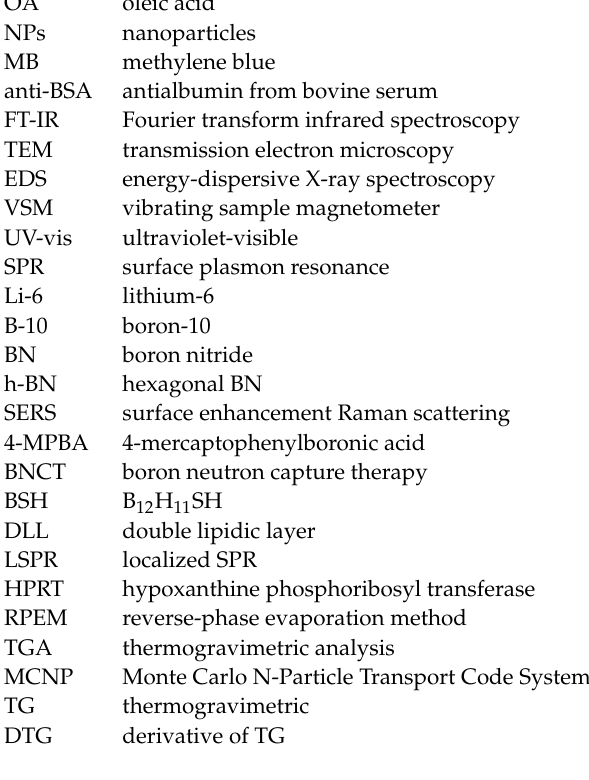
(a) TEM image of liposomes (b) Size distribution of minor axis of liposomes (c) Size distribution of major axis of liposomes, Figure S3: Standard curves of MB ultraviolet absorption peak, Figure S4: Optical photograph of MB released by neutron irradiation at different times, Figure S5:Stability of liposome composite after standing for different times 1 h (a), 360 h (b), the UV-vis absorbance of MB during 360 hours, Table S1: The relationship between the formation water and time, Table S2: Parametric record for calculating thermal neutron flux rate by activation method, Table S3. The parameters of self-shielding effect are